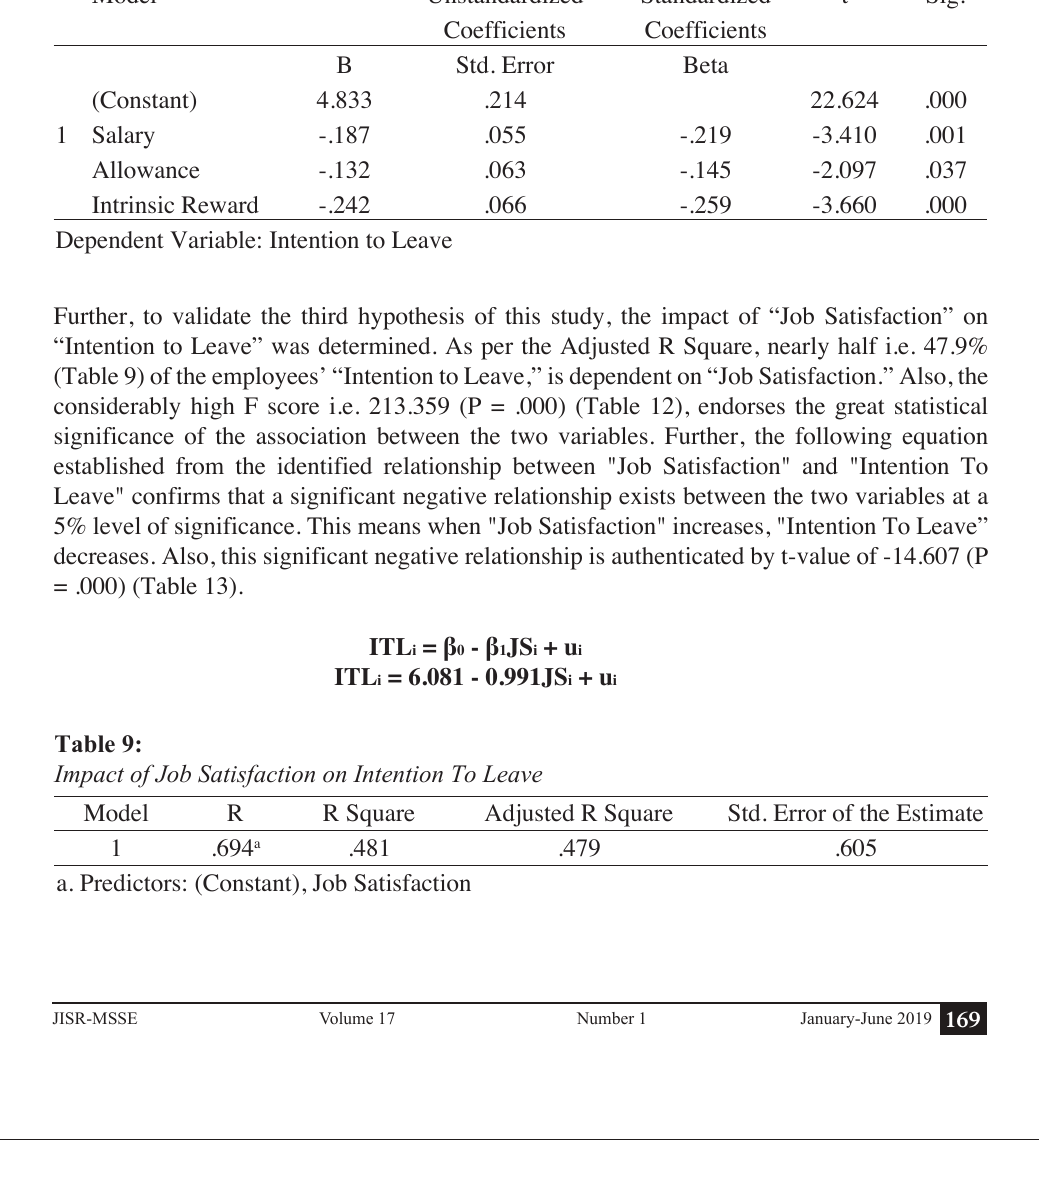
Table 8: Coefficients of Reward and Intention to Leave Model Unstandardized Standardized t Sig. Coefficients Coefficients B Std. Error Beta